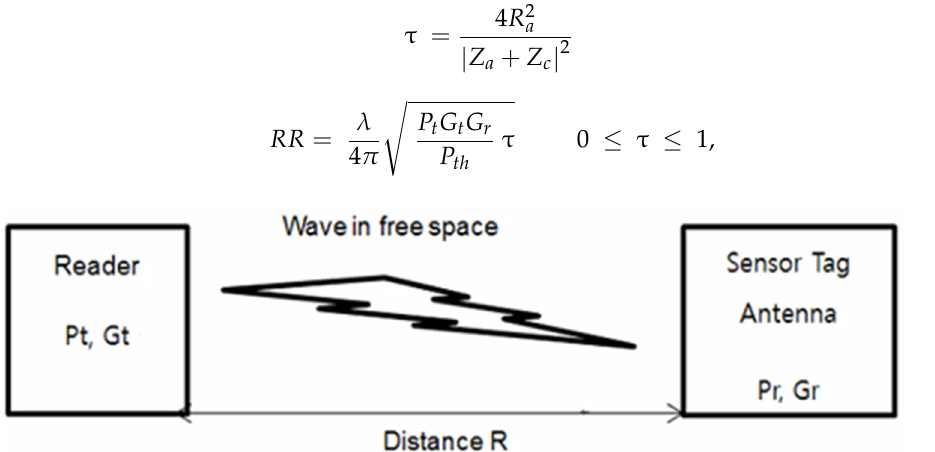
Figure 2. Propagation diagram in free space.